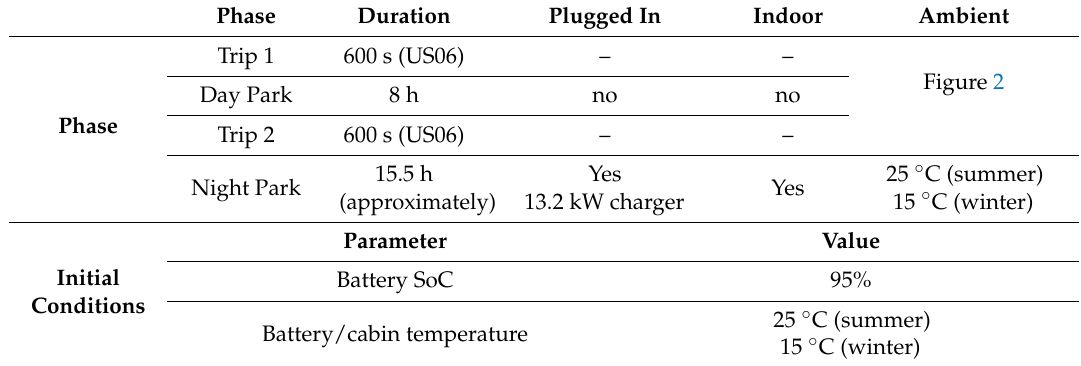
Table 1. Duty cycle assumptions.